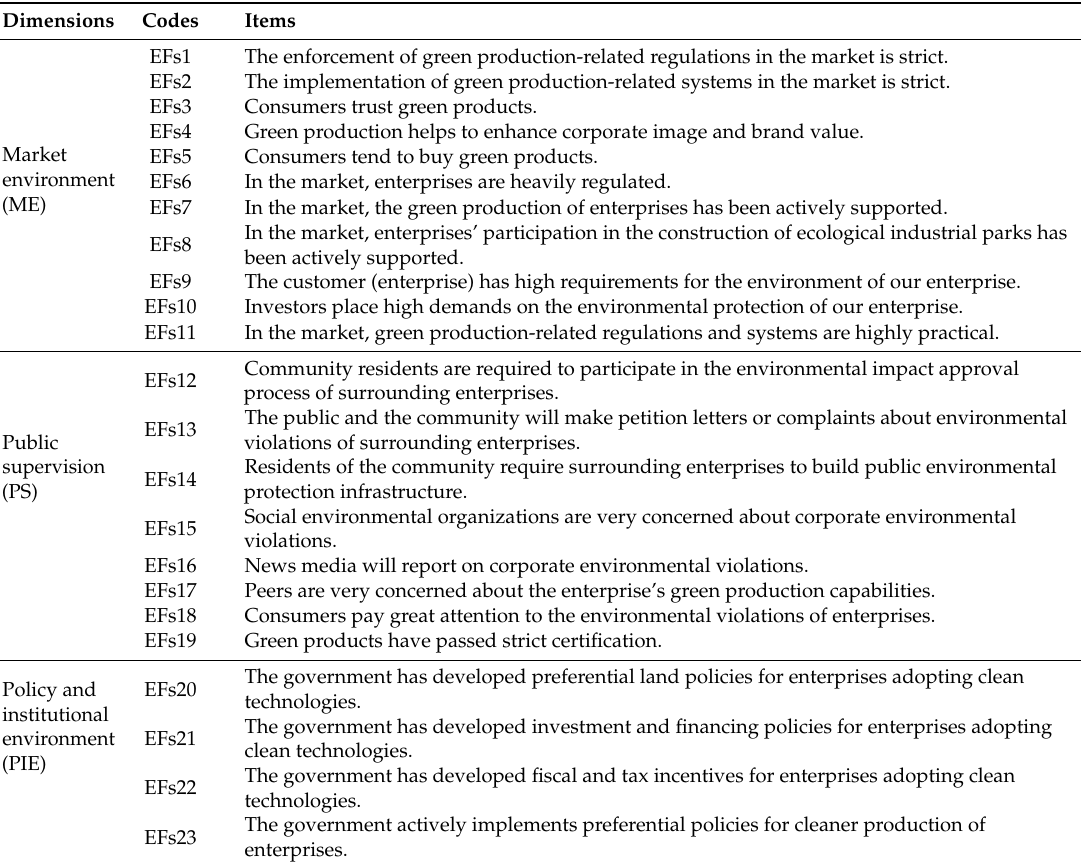
Table A2. Questionnaire items on the external factors (EFs) [22].